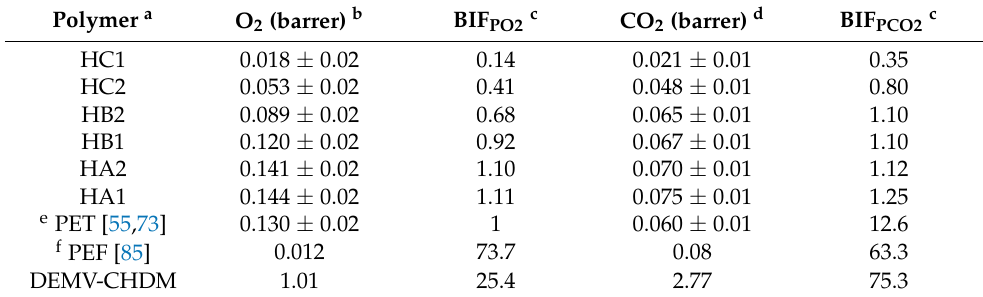
Table 4. O 2 /CO 2 Barrier properties of poly(ether-ester)s vs.